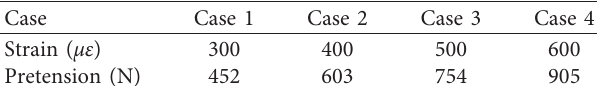
Figure 8: Layout of measuring points in the test model: (a) cable-strengthened structure model and (b) cable-free structure model. Table 1: Control strain of cable pretension.